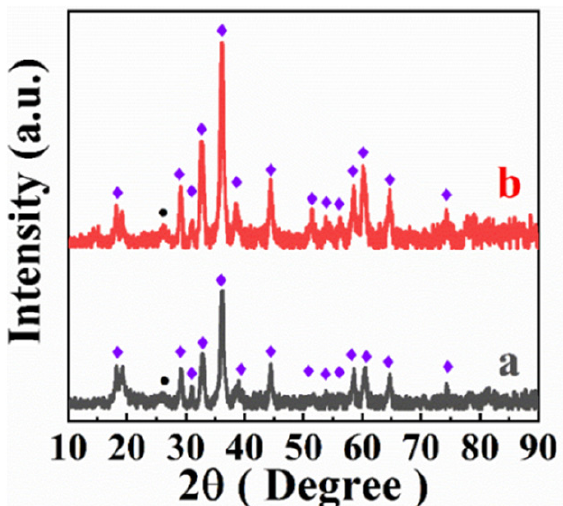
Figure 1. X-ray diffraction patterns of Mn 3 O 4 and MWCNT mixtures prepared by ( a ) method 1 and ( b ) method 2, ( ♦ -Mn 3 O 4 , ● -MWCNT).